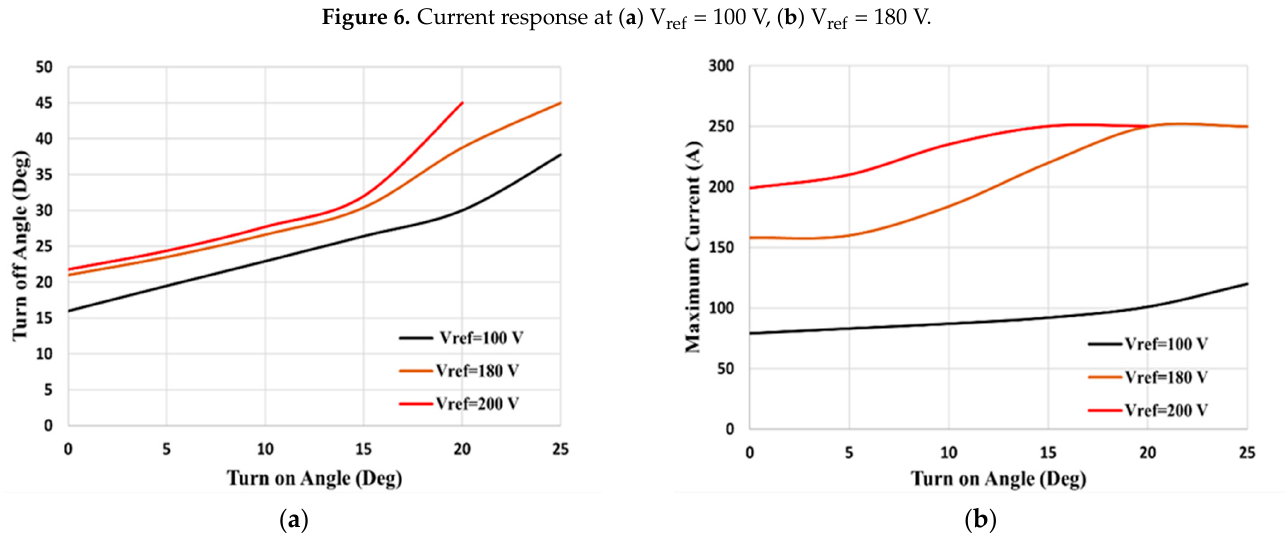
Figure 7. The effect of the initial turn-on angle on ( a ) the generated turn-off angle and ( b ) the maximum generated current at different reference output voltages.